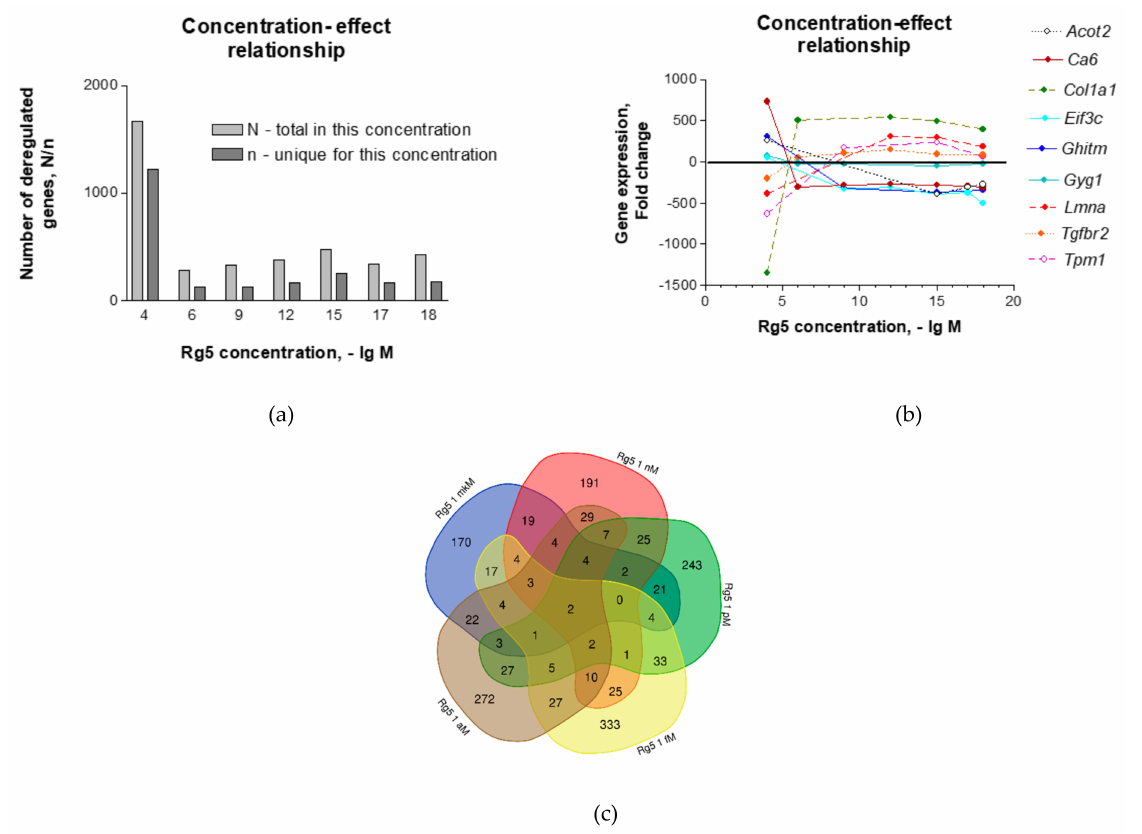
Figure 1. ( a ) The total number of genes deregulated by ginsenoside Rg5 in concentrations ranging from 1 µ M to 1 aM; ( b ) ginsenoside Rg5 concentration-dependent fold change expression of selected differentially regulated genes in the hippocampal neuronal cell line HT22; ( c ) Venn diagram of genes deregulated by ginsenoside Rg5 at concentrations 1 µ M, 1 nM, 1 pM, 1 gM and 1